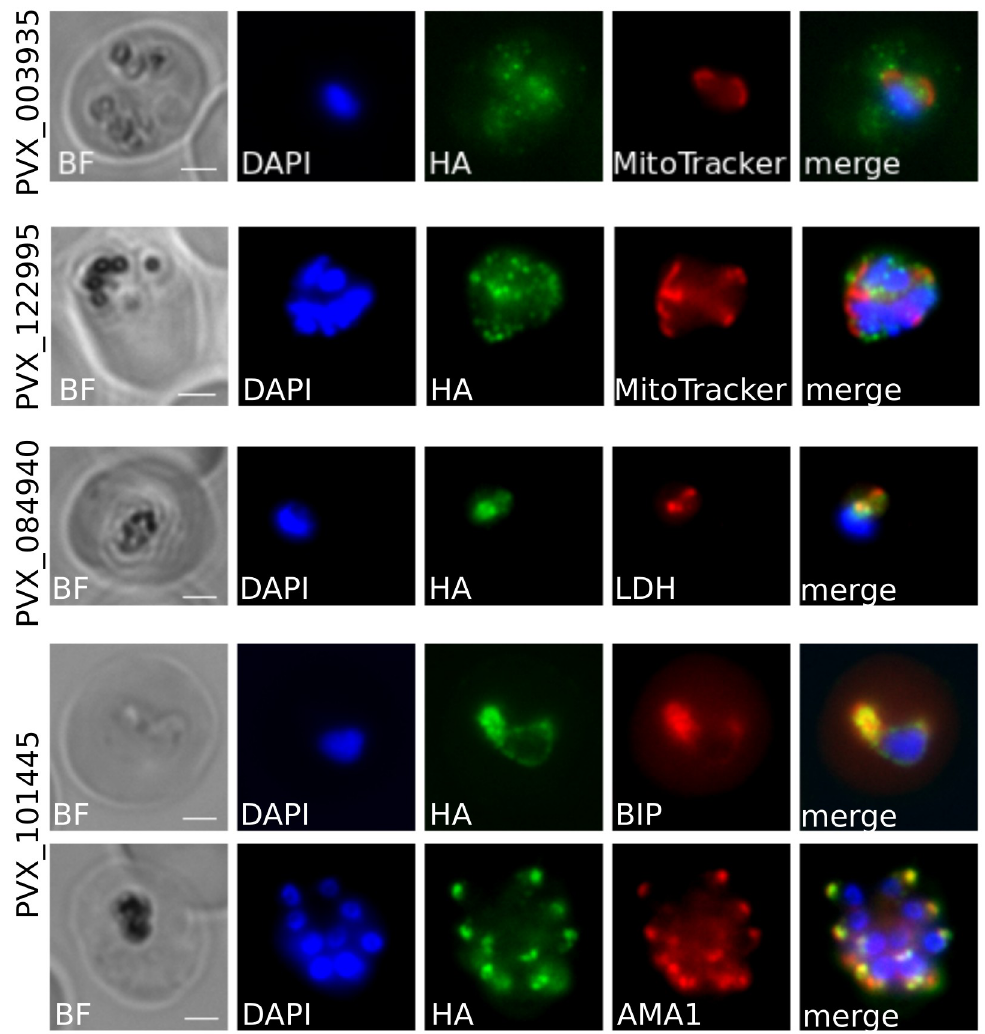
Fig 3. Localisation of PVX_101445, PVX_084940, PVX_122995 and PVX_003935 in P. knowlesi by immunofluorescence. P. vivax proteins were localised using either a rat α -HA antibody or a rabbit rat α -HA antibody. Both α -HA antibodies were conjugated with an AlexaFluor 1 488 secondary. Costaining markers AMA1, BiP and LDH were conjugated with an AlexaFluor 1 680 secondary antibody. MitoTracker CMXRos emits at 599 nm. Scale bar 2 μ